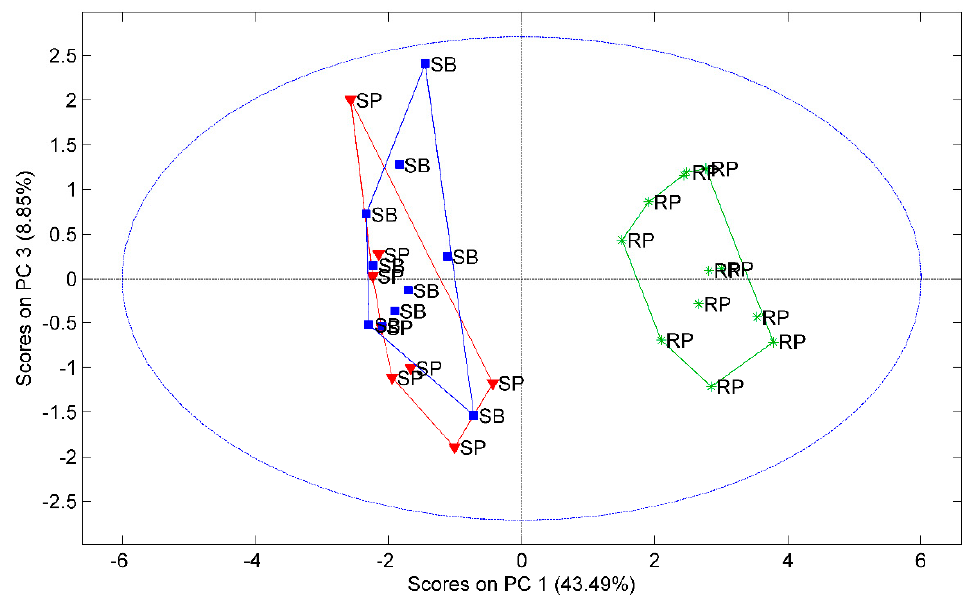
Figure 3. Principal Component Analysis (PCA) with pottery fragments excavated in three archaeo- logical sites, Sambaqui do Bacanga (SB), Sambaqui da Panaquatira (SP), and Rabo de Porco (RP).